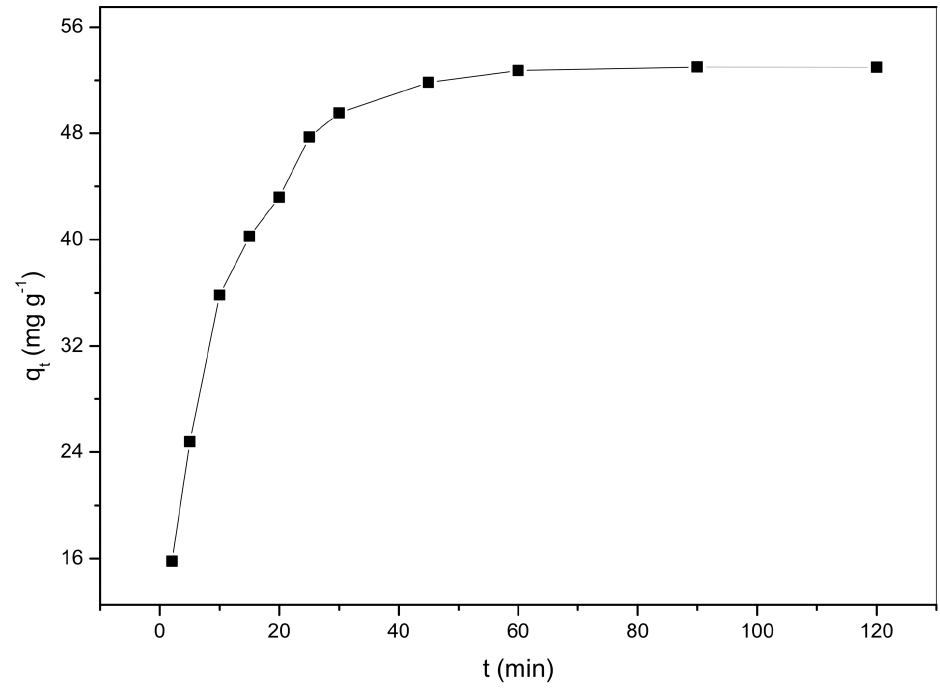
Figure 2. Effect of contact time on the biosorption of Cd 2 + by Sargassumfusiforme .